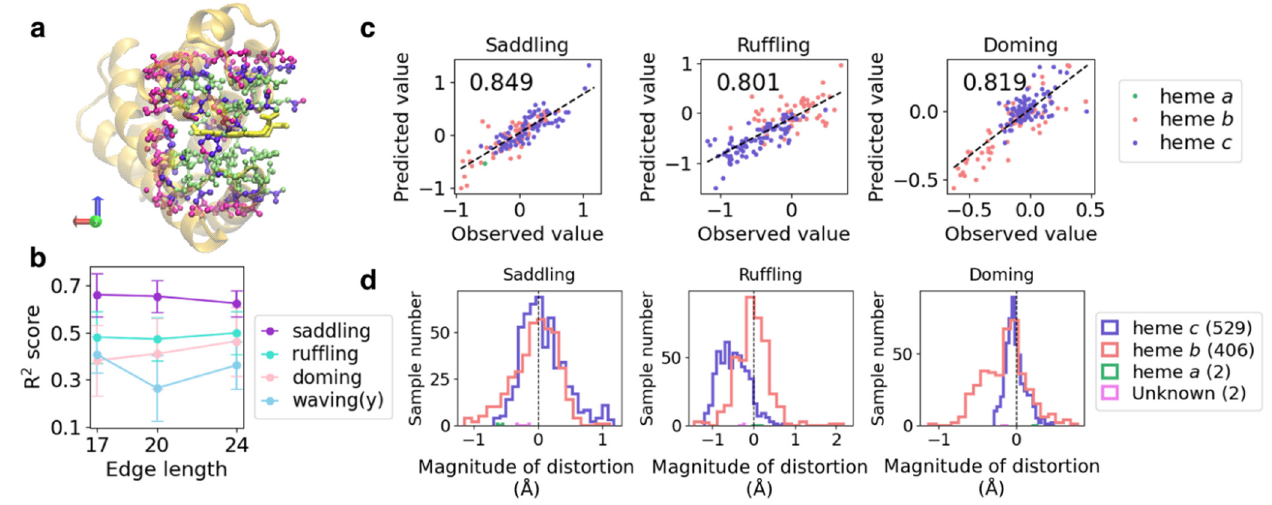
Figure 3. ( a ) Atoms in the inclusion region with the edge length of 17 (lime), 20.0 (violet), and 24.0 (magenta) Å, as exemplified by PDB ID: 1mba. The whole protein structure and heme molecule are shown as the orange cartoon and the yellow licorice model, respectively. ( b ) Plot of R 2 scores averaged over five cross-validation runs versus the edge length of the input voxels for each heme distortion. ( c ) Correlation between the predicted and observed values in the test dataset of the best model among five cross-validation runs for each heme distortion. Values on the upper left of each panel represent correlation coefficients. Slate-blue, light-coral, and sea-green points indicate heme c , b , and a , respectively. ( d ) Distribution of saddling, ruffling, and doming distortions for each heme type in the non-redundant dataset.